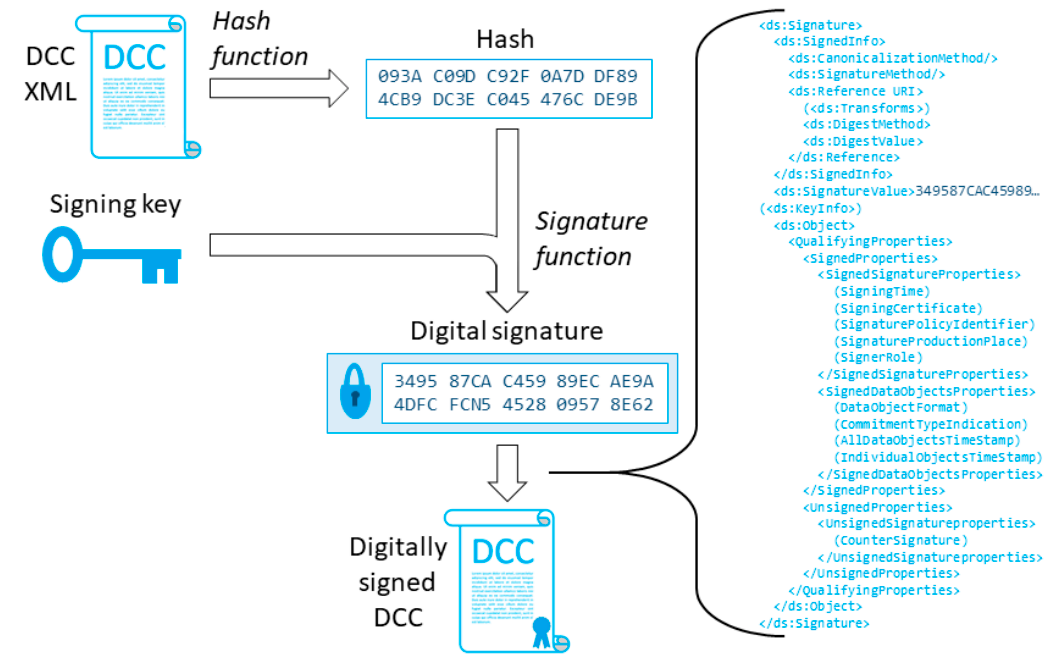
Figure 3. A general example of the process for digitally signing a DCC.